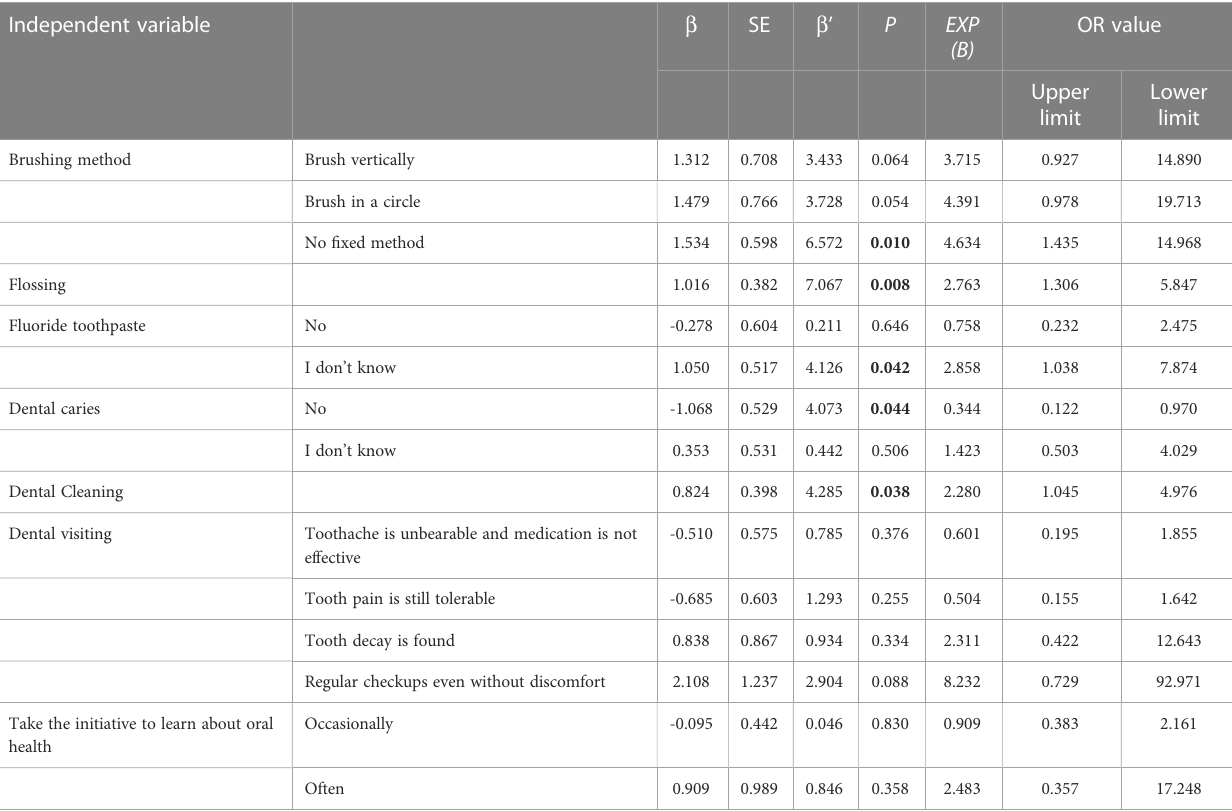
TABLE 4 Binary and multivariate logistic regression analyses of oral health behaviors and oral health service utilization across urban and rural cancer patients controlling for demographics. Independent